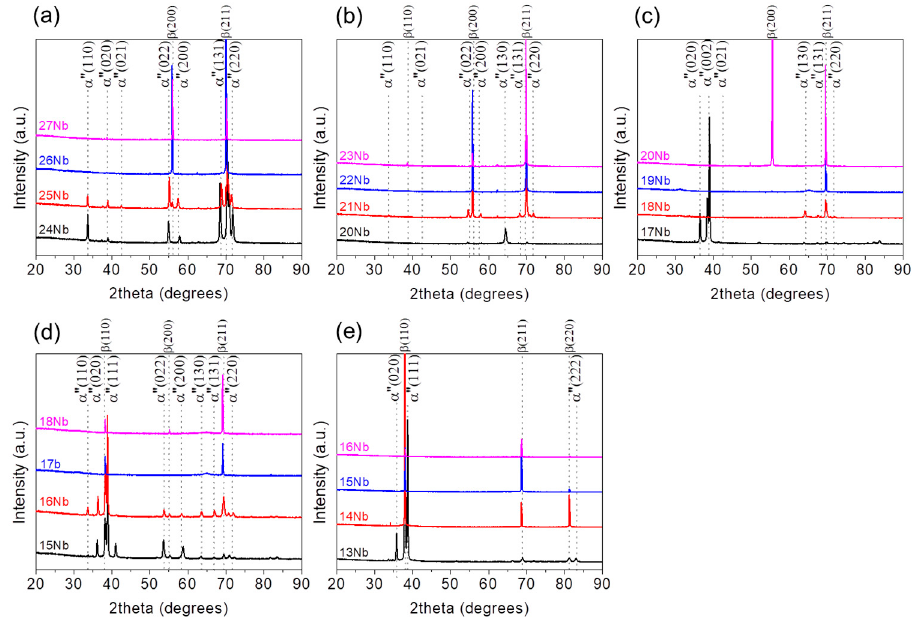
Figure 2. XRD profiles of Ti–Nb–Zr alloys obtained at room temperature: ( a ) Ti–(24–27)Nb; ( b ) Ti–(20–23)Nb–4Zr; ( c ) Ti–(17–20)Nb–8Zr; ( d ) Ti–(15–18)Nb–12Zr; ( e ) Ti–(13–16)Nb–18Zr alloys.